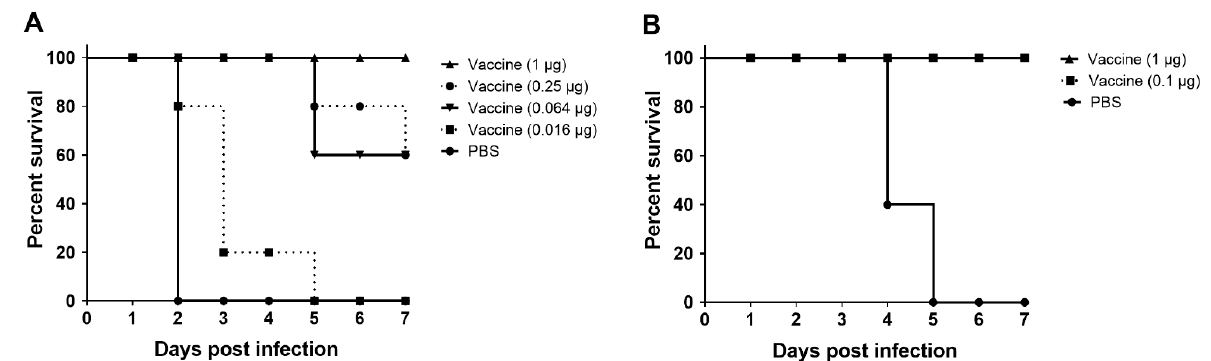
Figure 6. Heterologous virus challenge in mice vaccinated with the A/SKR/Yeoncheon/2017 (A-1) experimental vaccine. C57BL/6 mice were intramuscularly injected with the A/SKR/Yeoncheon/2017 experimental vaccine or phosphate-buffered saline (PBS). Each animal was inoculated with vaccine containing serially 1/4 diluted antigen (1, 0.25, 0.063, or 0.0016 µ g) per animal ( A ) or 1 or 0.1 µ g of antigen per animal ( B ). The animals were challenged with 200 LD 50 of mouse-adapted FMDV A/MAY/97 via intraperitoneal injection at 10 ( A ) or 21 ( B ) days post-vaccination (DPV). Survival was monitored for 7 days.